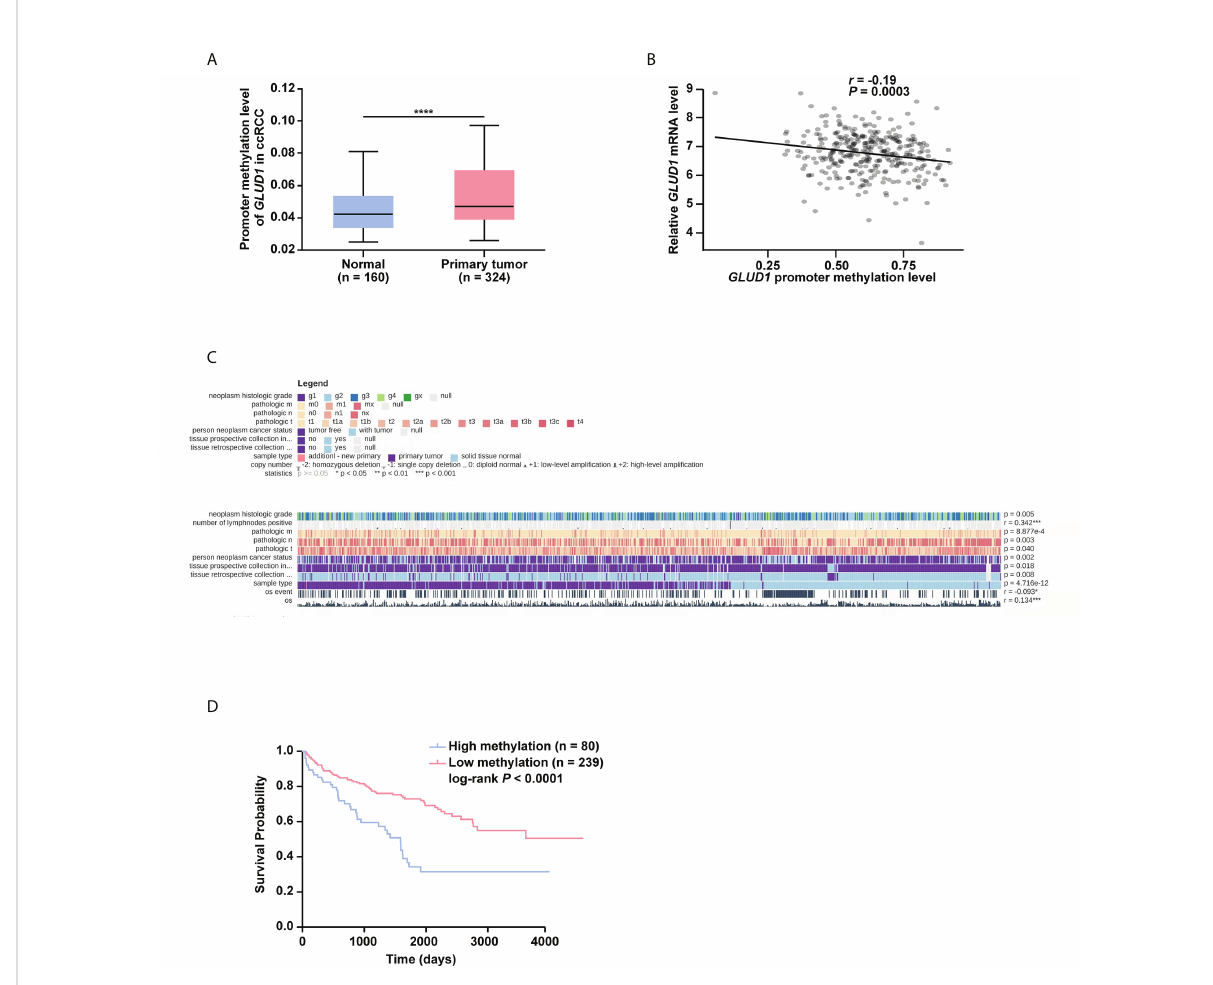
FIGURE 3 High level of methylation in GLUD1 promoter leads to the downregulation of GLUD1 level in ccRCC tissues and correlates with shorter survival of ccRCC patients. (A) Methylation levels of GLUD1 promoter was increased in ccRCC tissues based on the TCGA_KIRC data. The Beta value indicated the level of DNA methylation, and the P value was derived from independent sample two tailed t -test. The data were presented as mean ± SD. **** P < 0.0001. (B) The correlation between methylation levels of GLUD1 promoter and GLUD1 mRNA level. (C) The correlation between GLUD1 methylation levels and clinical parameters in the MEXPRESS database. (D) KM curve of methylation levels of GLUD1 promoter based on the TCGA data. **** P <